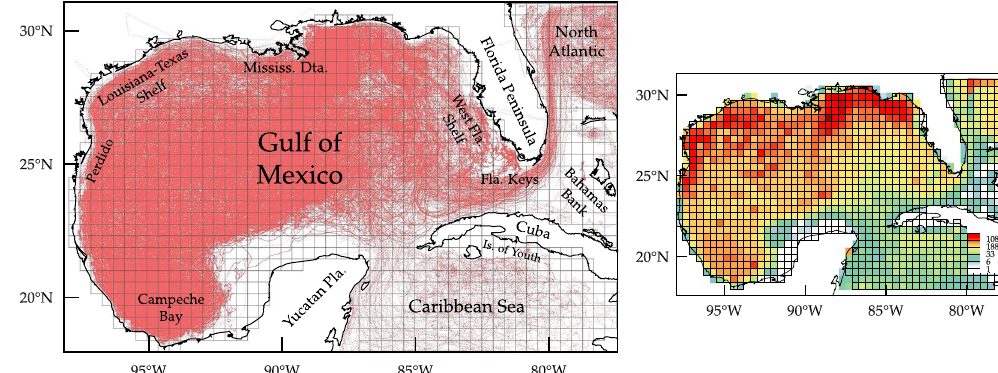
Figure 1. (left) “Spaghetti” plot of all daily satellite-tracked drifter trajectories describing the surface-ocean Lagrangian dynamics in the extended Gulf of Mexico (eGoM) domain. The finite grid used to construct a Markov-chain representation of the dynamics is shown in black. (right) Number of drifters per grid bin independent of the day over 1994–2016 subjected to a fourth-root transformation. Figures constructed using Matlab R2017a (http://www.mathworks.com/) and Tecplot 360 2016 R2